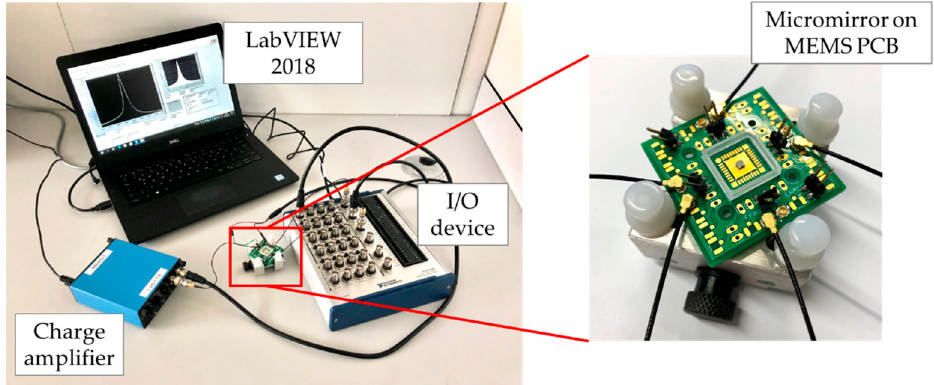
Figure 14. Photograph of the sensor characterization setup.